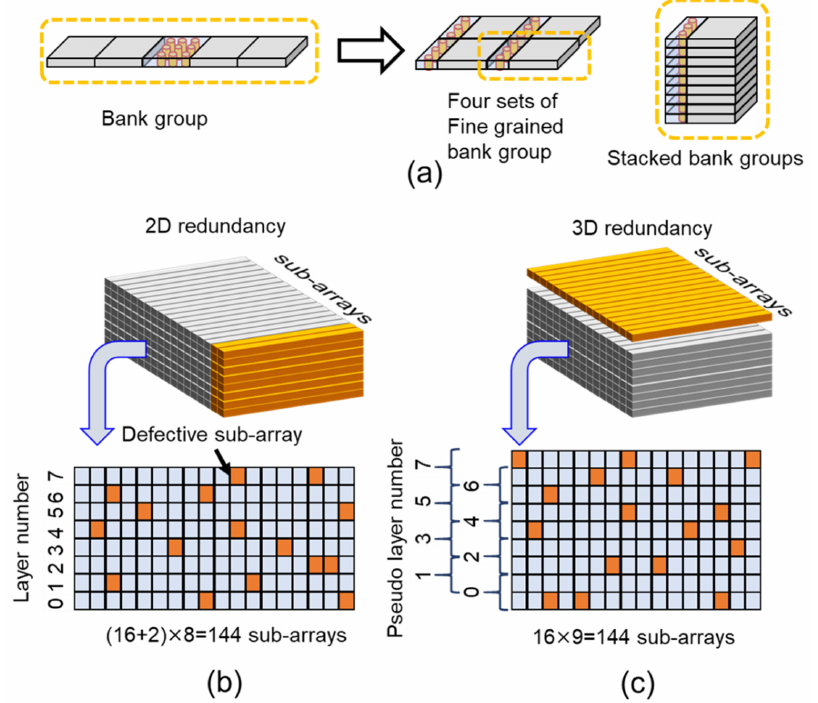
Figure 50. ( a ) Cases where each bank group (tile) may involve only one bank, or one pseudo bank. ( b ) In the case where 2 more redundant sub-arrays give near 100% yield, more than 127 non-defective sub-arrays are included in 144 sub-arrays. ( c ) In case of the same defective rate as ( b ), stack of single bank tiles with 1 extra layer tile includes 16 defective sub-arrays at most.